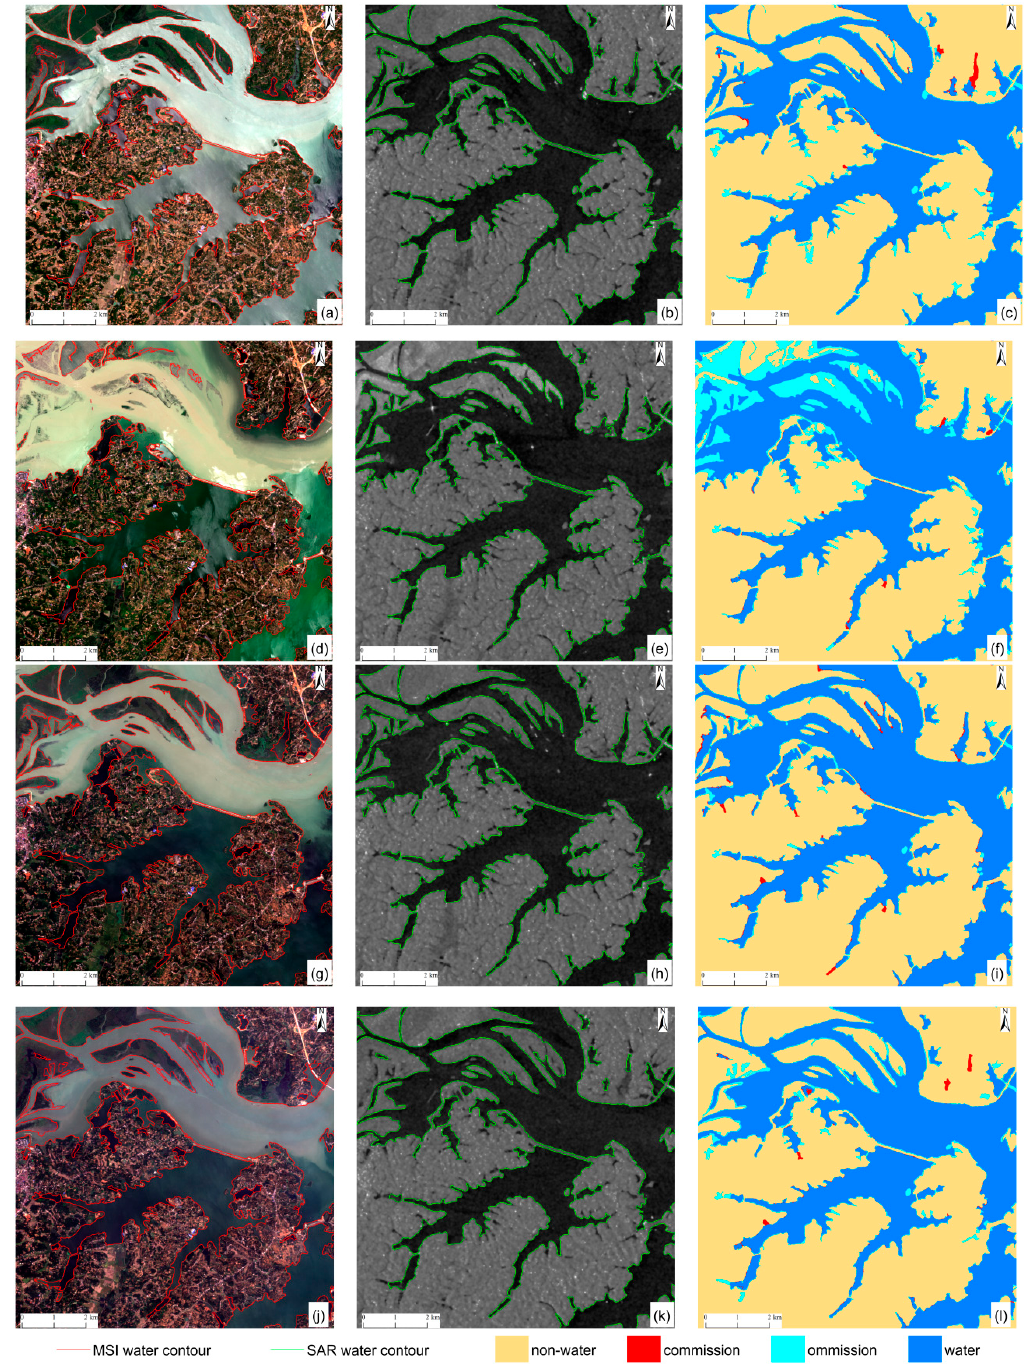
Figure 6. The extracted water contours and final water classification overlays for Sentinel-2 MSI (as reference) and Sentinel-1 SAR for the test site B: ( a ), ( d ), ( g ), and ( j ) are water contours using the AWEI method and true color compositions of the Sentinel-2 MSI acquired on 18 May 2017, 17 July 2017, 15 September 2017, and 5 October 2018, respectively; ( b ), ( e ), ( h ), and ( k ) are extracted water contours using the proposed method and Sentinel-1 SAR scene in VV polarization acquired on 23 May 2017, 22 July 2017, 20 September 2017, and 9 October 2018, respectively; ( c ), ( f ), ( i ), and ( l ) are overlays of final water classification from Sentinel-1 SAR and Sentinel-2 MSI.